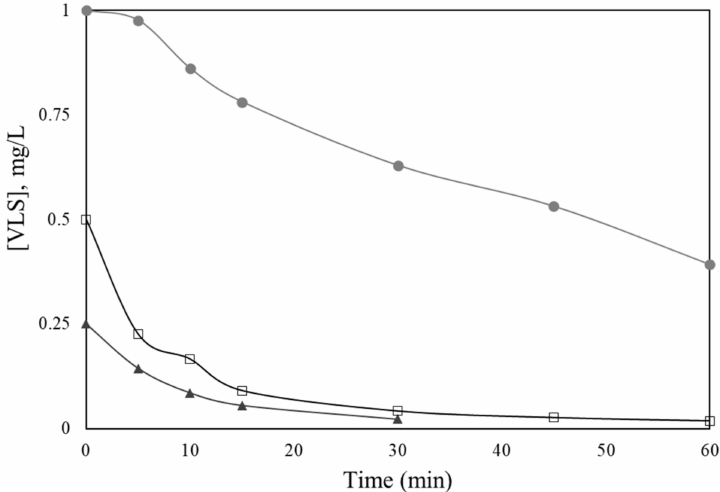
Figure 6. Effect of VLS concentration on its degradation with 1000 mg/L 0.25 MoS 2 /BiOCl in UPW under solar